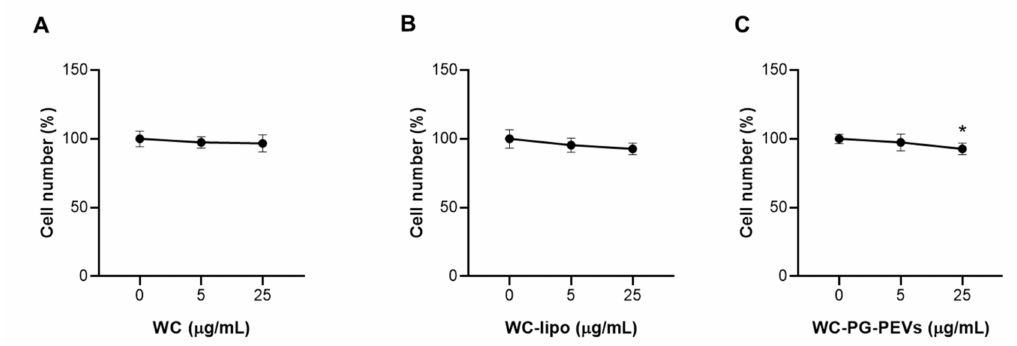
Figure 2. Effect of free WC ( A ), WC liposomes ( B ), and WC PG-PEVs ( C ) on cell viability. U937 cells were counted after 48 h exposure to WC, WC liposomes, and WC PG-PEVs (5 and 25 µ g/mL). Means ± S.D. of three replicate independent experiments are shown. Statistical significance of differences was determined by one-way ANOVA followed by Dunnett’s test; * p < 0.05. Abbreviations: WC, free WC; and WC-lipo, WC